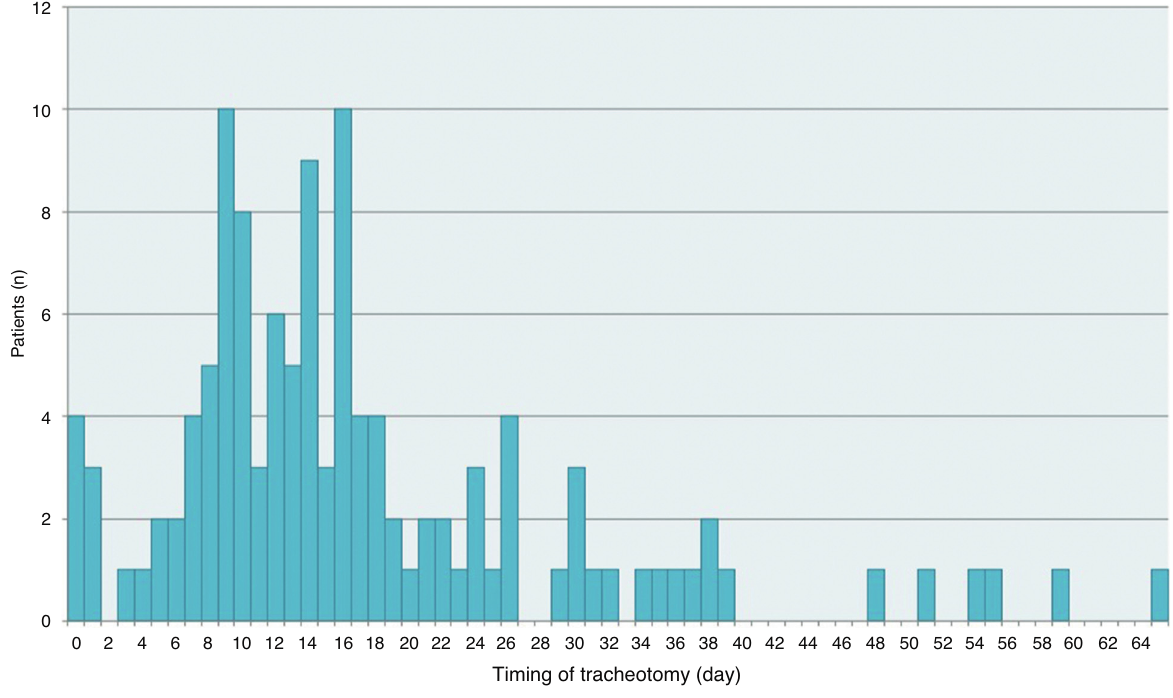
Figure 2 Distribution of patients by timing of